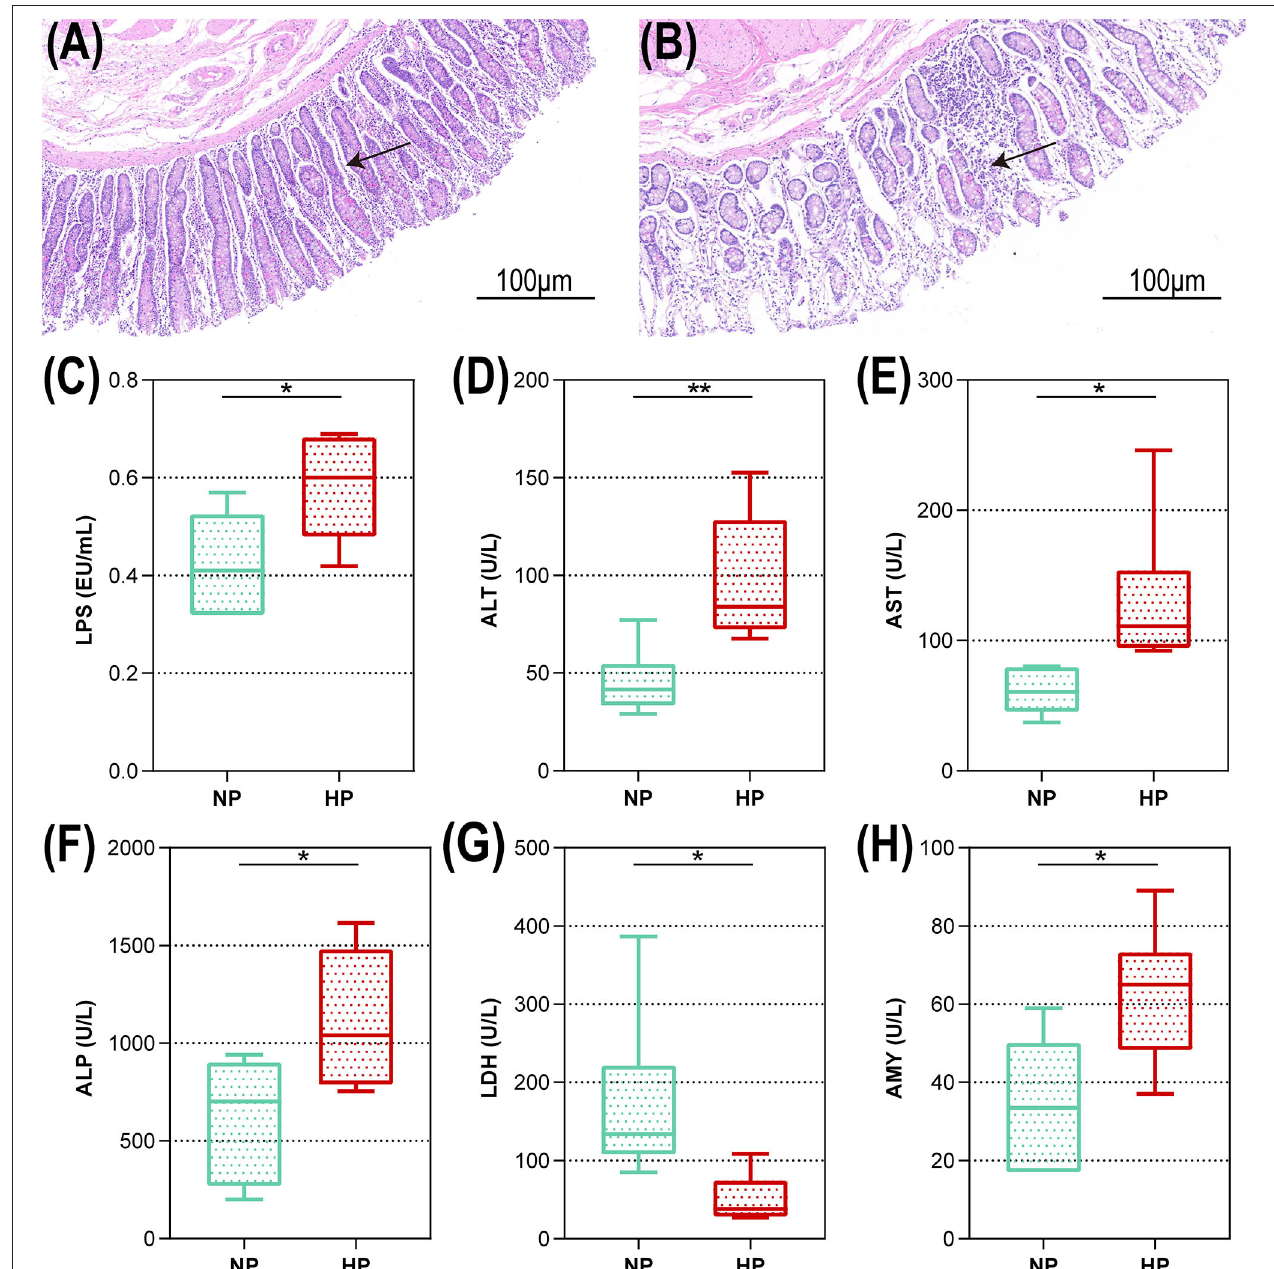
FIGURE 1 | Intestinal morphology and cecal metabolites of goats fed NP and HP diet. Light microscopy cross-section of hindgut tissue from a representative NP-fed goat [ (A) scale bar = 100 µ m] or HP-fed goat [ (B) scale bar = 100 µ m]. (C–H) Metabolic parameters of the hindgut to goats fed by NP and HP diets. *0.01 < p < 0.05; ** p < 0.01. The arrow indicate the observation of intestinal epithelial